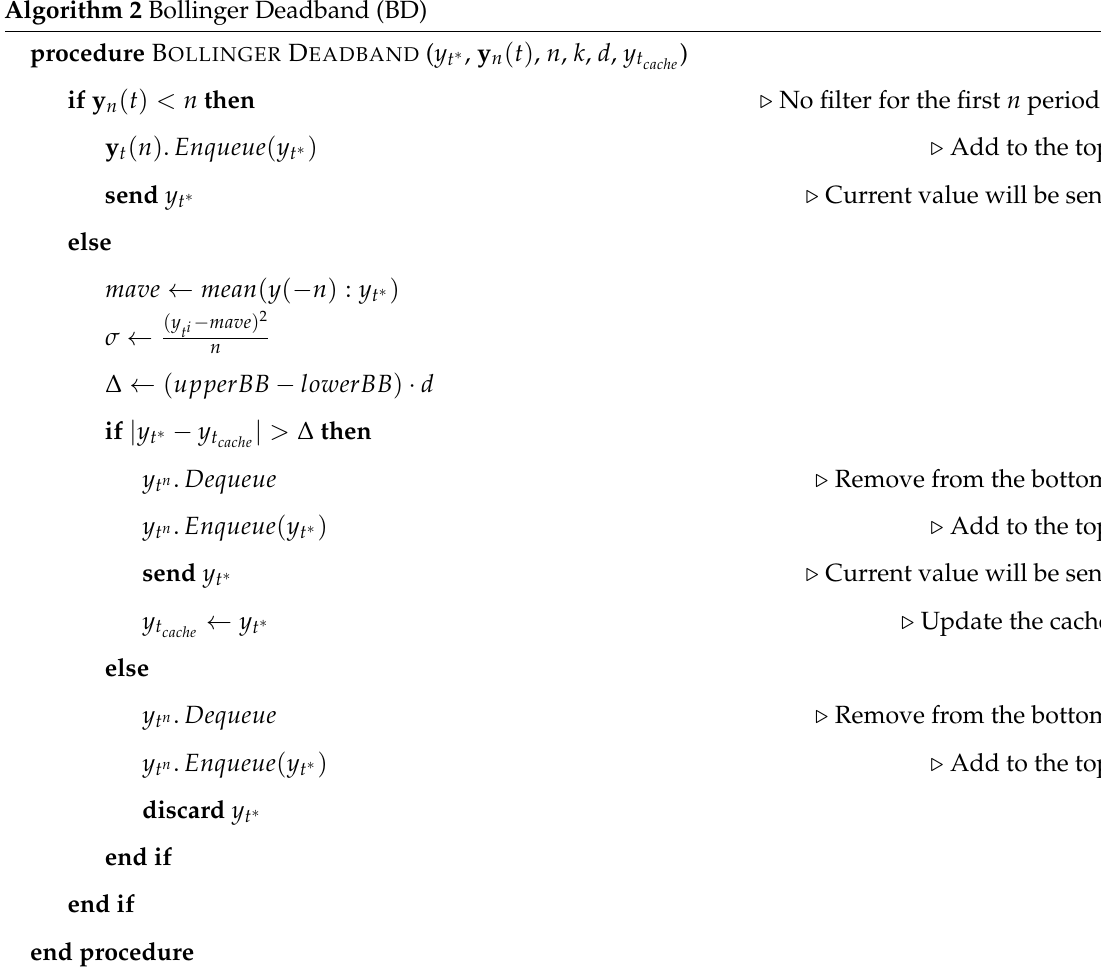
Algorithm 2 Bollinger Deadband